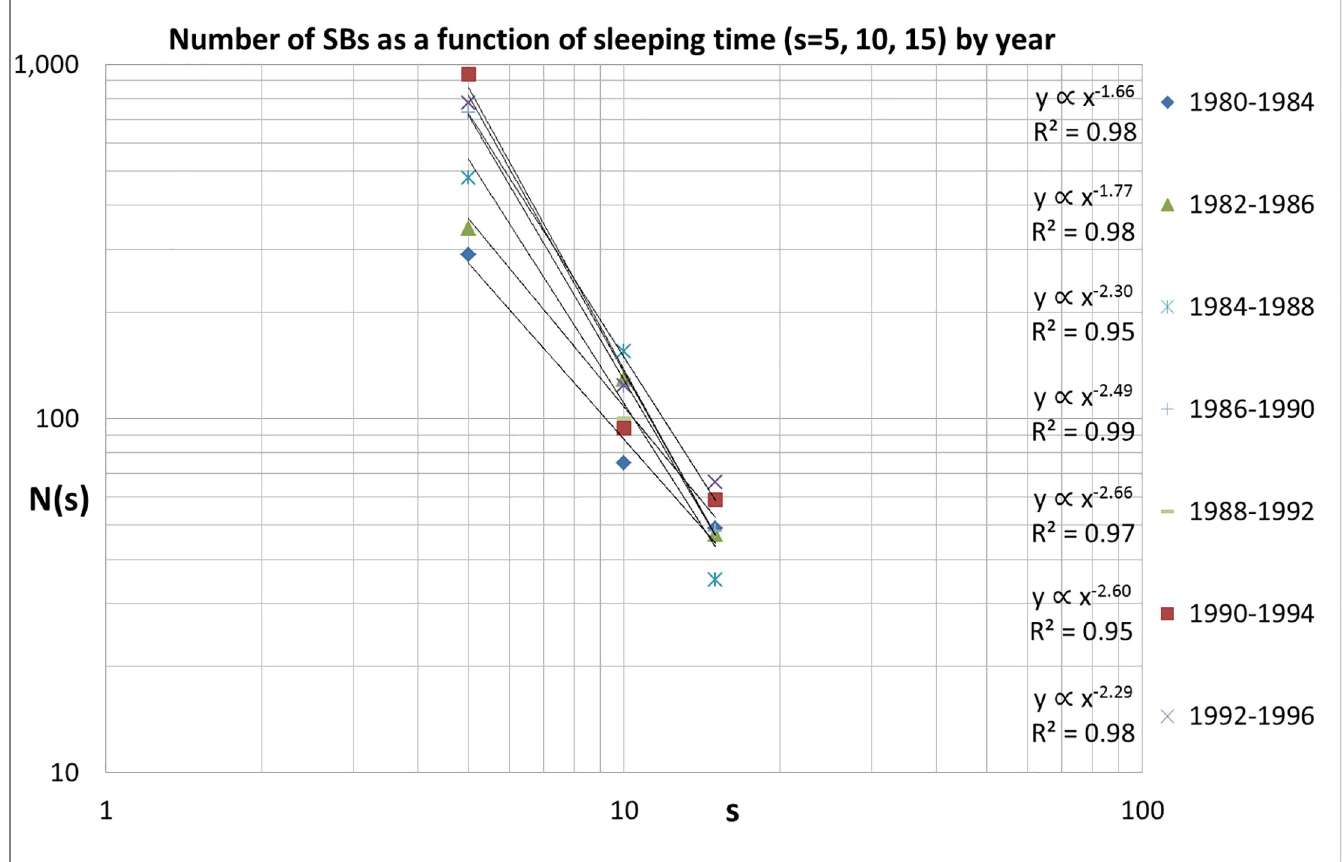
Fig 5. Number of SBs for s = 5, 10, 15 between 1980 and